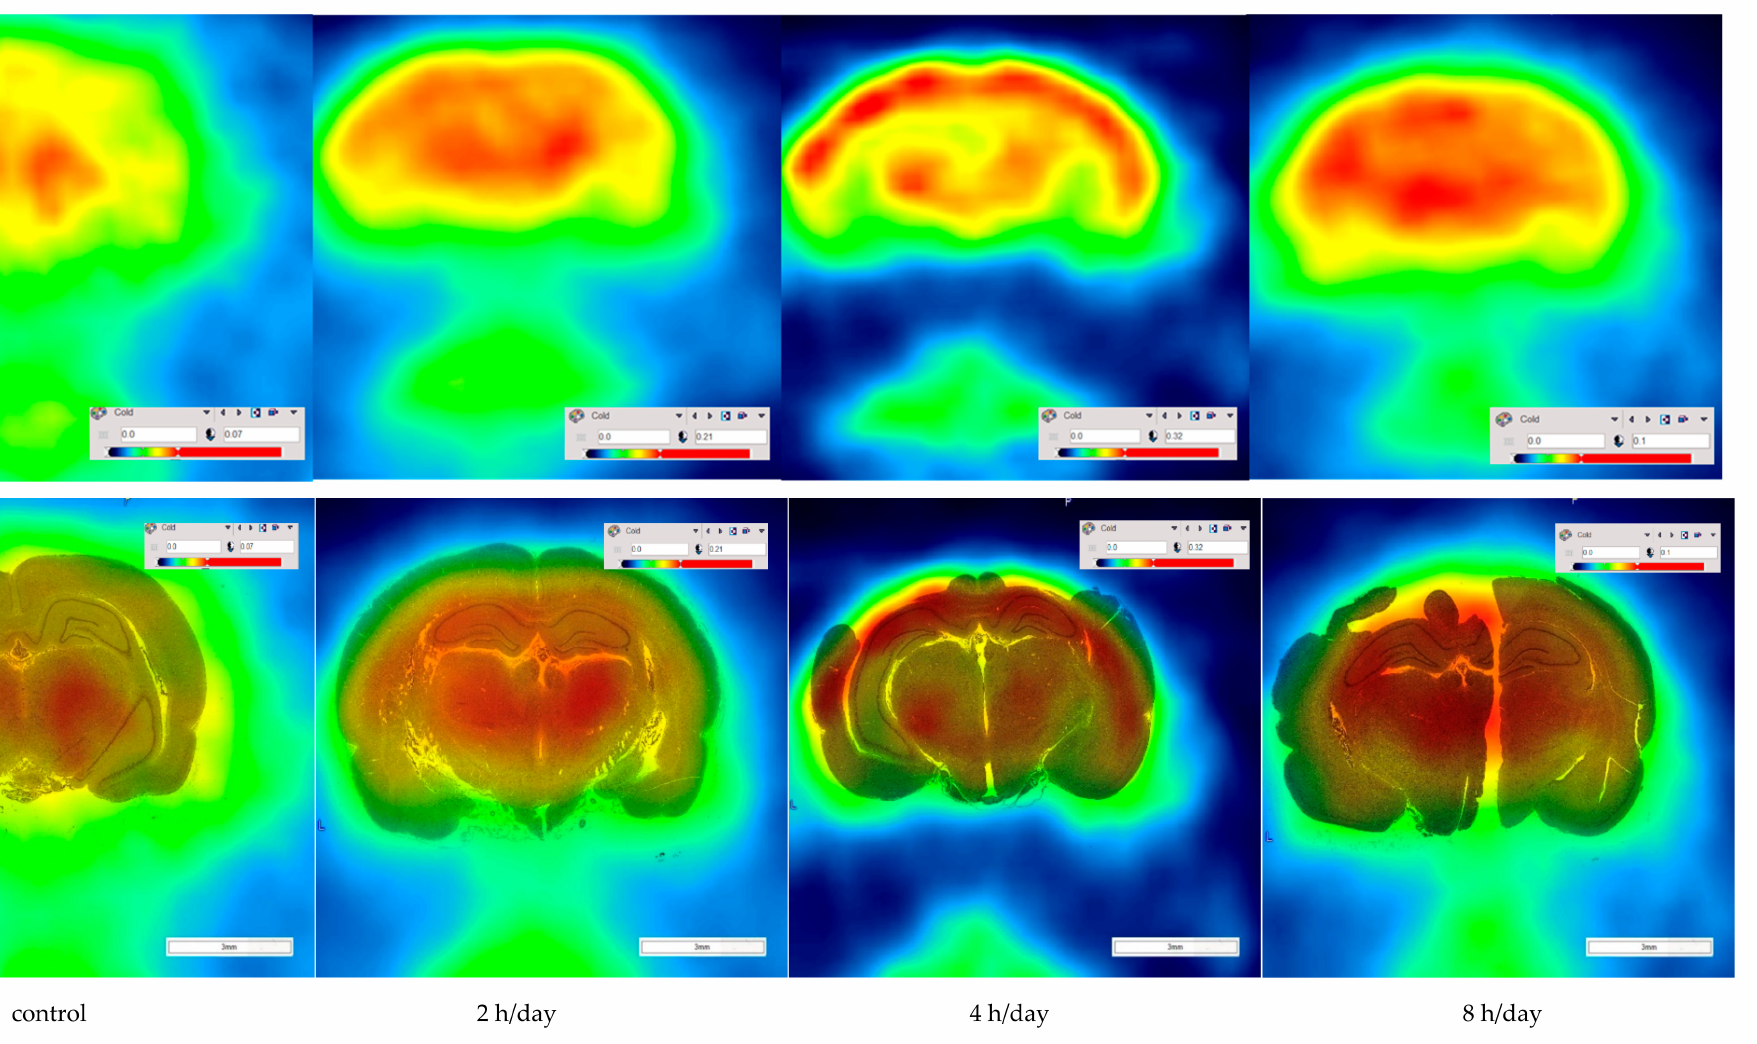
Figure 7. Micro PET-CT imaging on immunohistochemistry. The metabolism in each brain region was shown in each group at 5 days rest after